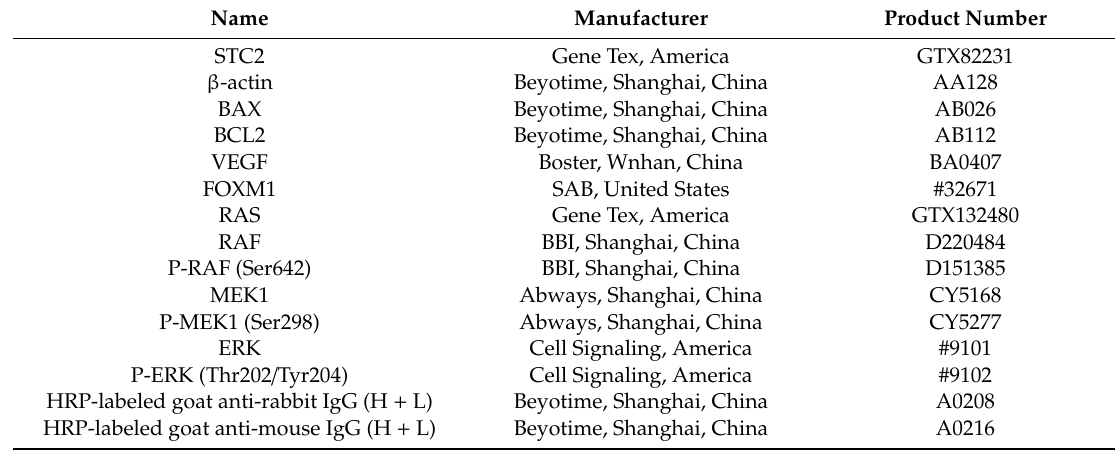
Table 2. Antibody